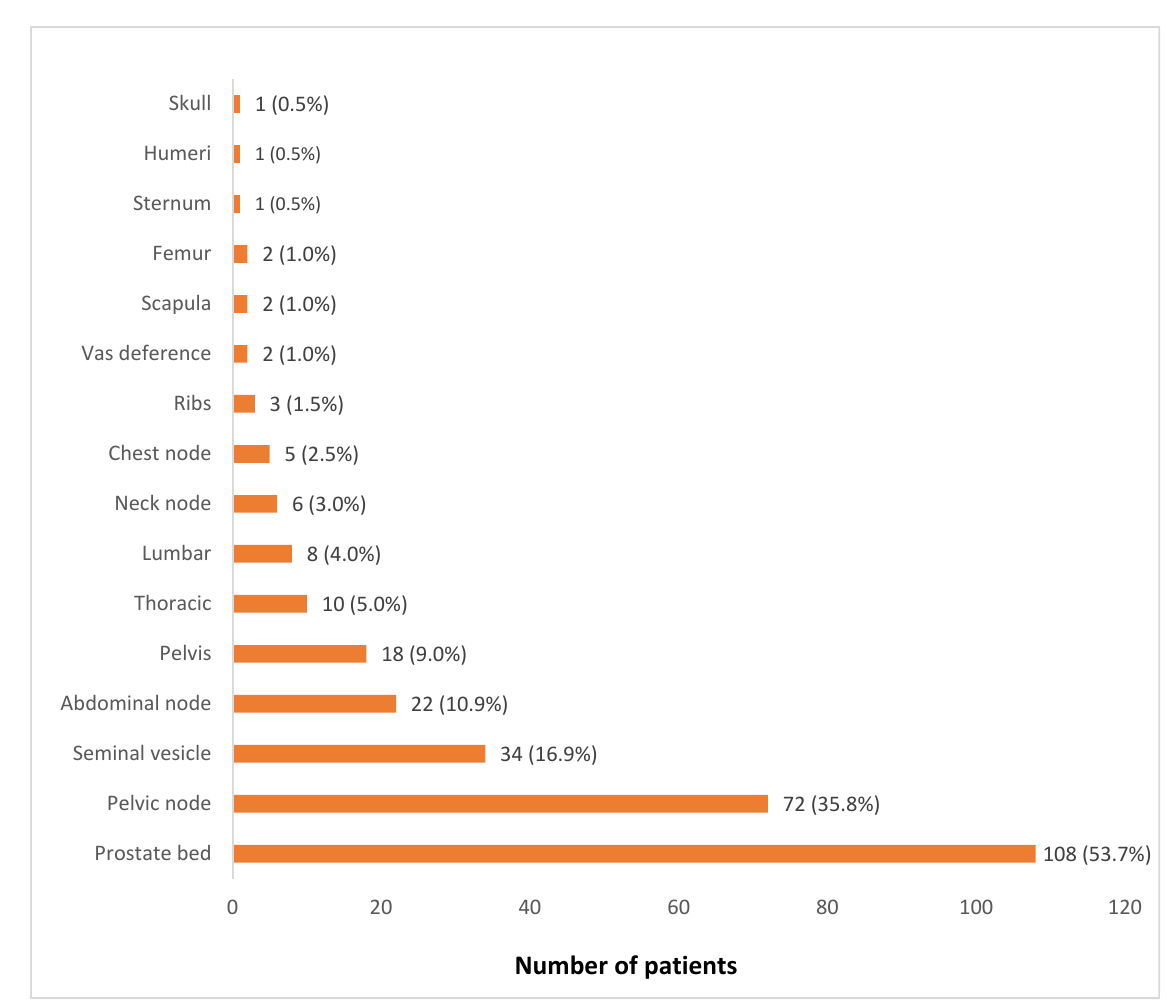
Figure 1. Distribution of the sites of recurrence of prostate cancer. Table 2. Relationship between PSA level and number of lesions among patients with positive 68 Ga-PSMA-11 PET/CT finding for recurrence.